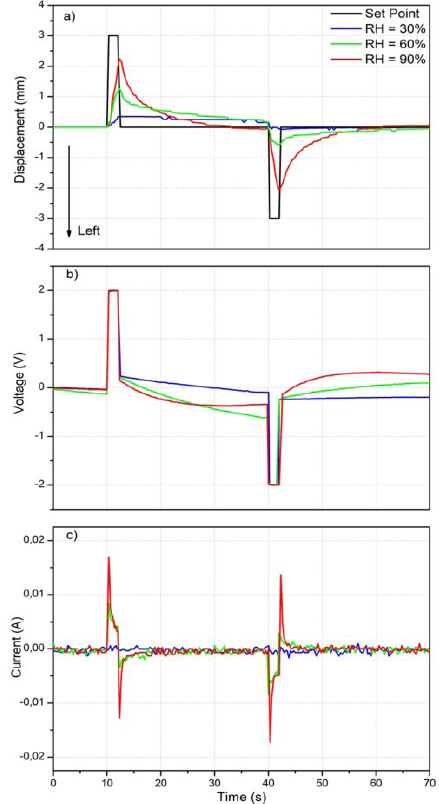
Figure 6. IPMC electromechanical response as a function of Time for a square pulse stimulus. a) Displacement (mm), b) Voltage (V), and c) Current (A).